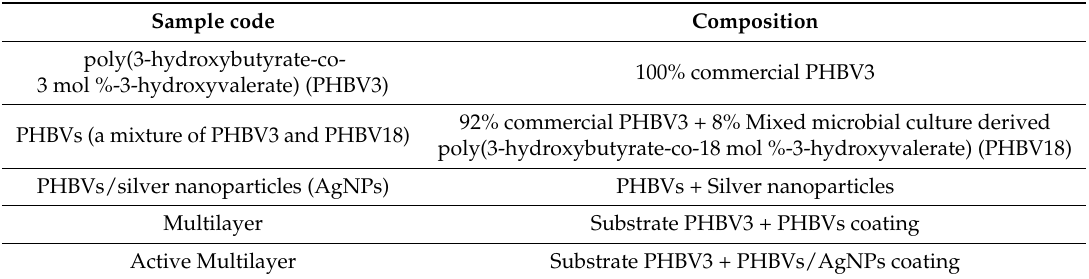
Table 1. Sample code and composition of the developed